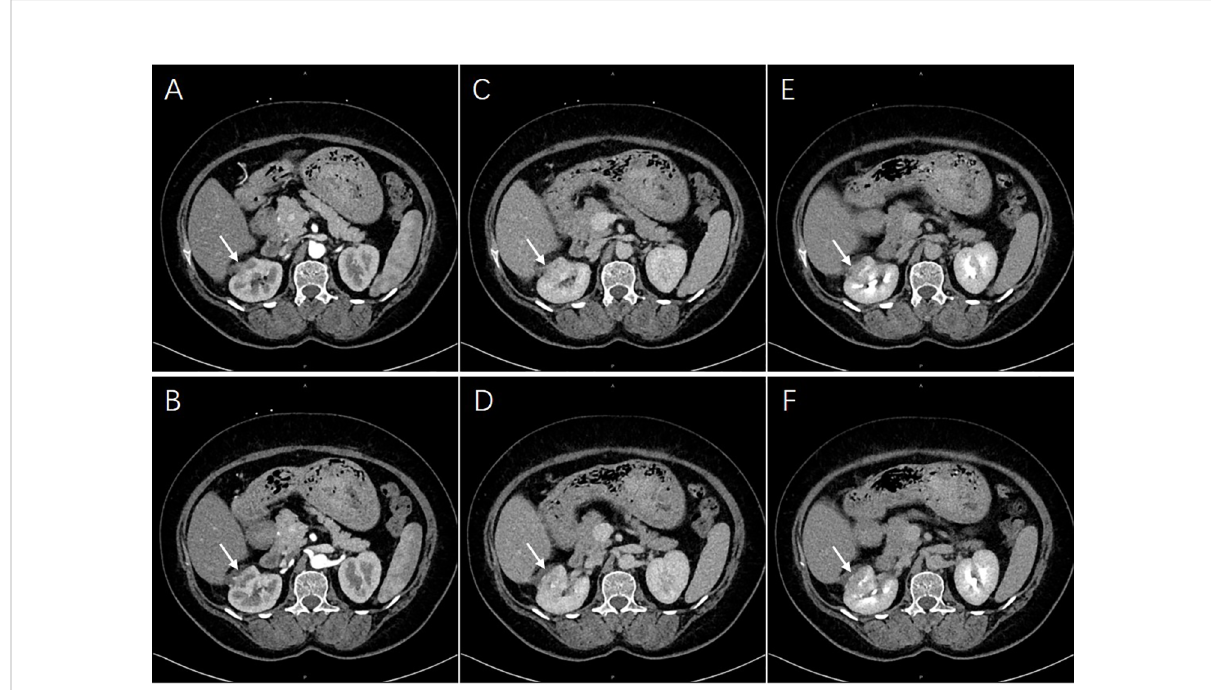
FIGURE 4 The lesions were diminished. They were enhanced equally with renal parenchyma in arterial [ (A, B) , arrows] and venous phases [ (C, D) , arrows], while less degree in excretory phase [ (E, F) ,